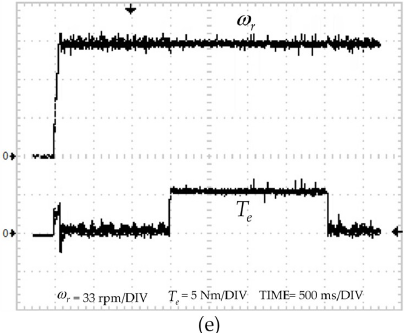
Figure 8. Experimental results when step speed from standstill to 100 rpm then 100% step-load change ( a ) actual speed response ( ω r ), estimated speed response ( ˆ ω r ) and estimation error ( ω r − ˆ ω r ) when motor starting, ( b ) actual speed response ( ω r ), estimated speed response ( ˆ ω r ) and estimation error ( ω r − ˆ ω r ) during taking load, ( c ) stator flux trajectory when no load, ( d ) stator flux trajectory when full load, ( e ) actual speed response ( ω r ) and torque response ( T e